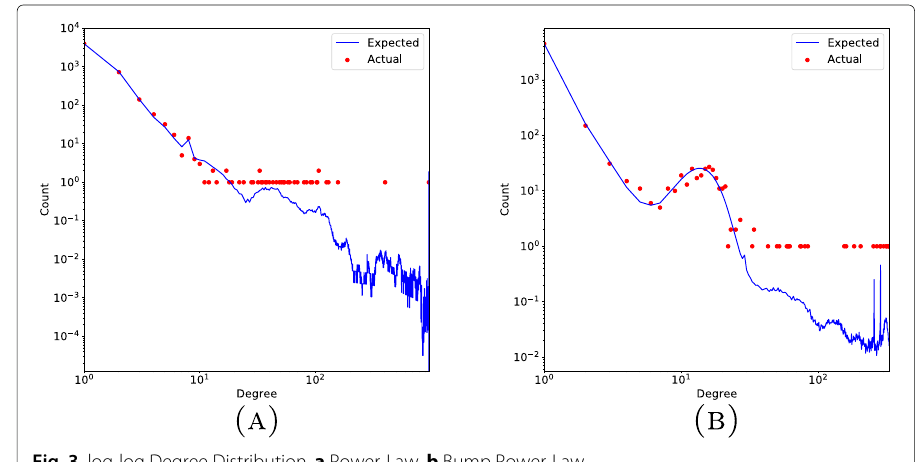
Fig. 3 log-log Degree Distribution. a Power-Law. b Bump